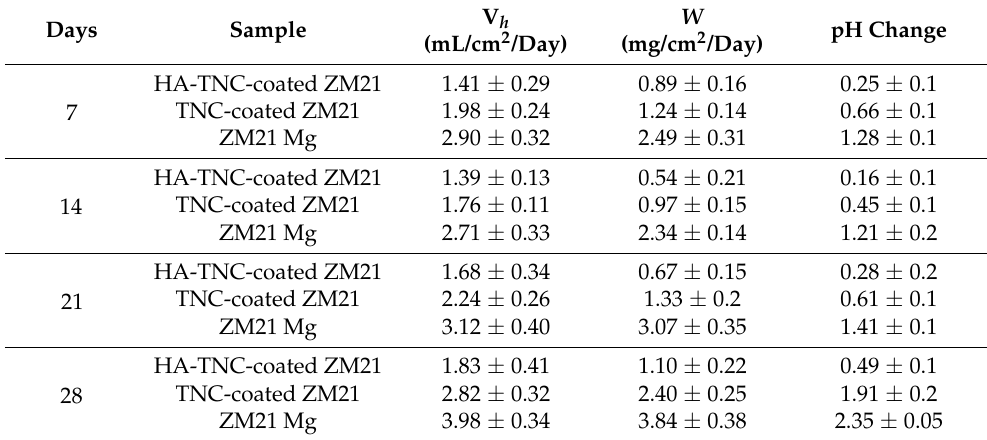
Figure 7. In vitro immersion study showing ( a ) weight loss (%), ( b ) in vitro degradation rate, ( c ) HER, and ( d ) pH change of immersion media, corresponding to HA-TNC-coated ZM21, TNC-coated ZM21, and polished ZM21 samples. Table 2. The hydrogen evolution rate (V h ), degradation rate ( W ), and pH change of ZM21 samples during 28 days of immersion in